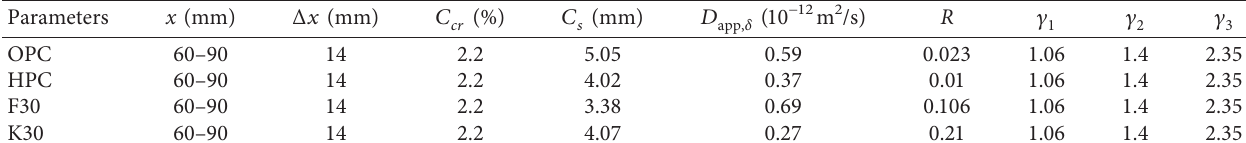
Table 3: Significant impact factors on concrete service life prediction.